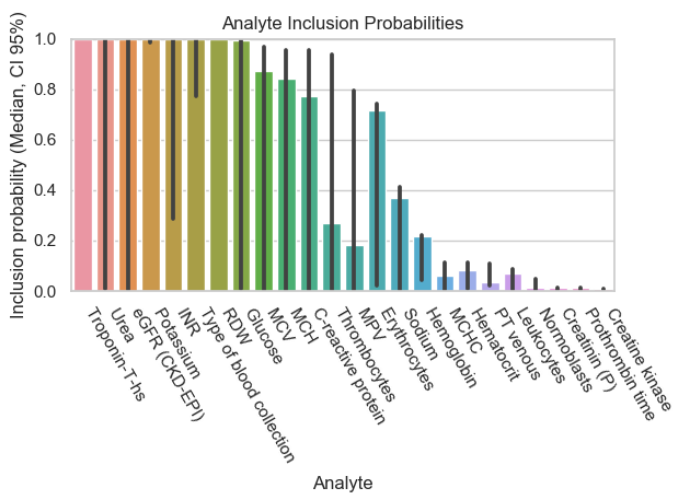
Figure 2. Inclusion probability of parameters based on a data subset with initially 40% missing values. More analytes have a high predictive value with a bigger data subset. Those showing an inclusion probability of 95% and above are the following: TnT, potassium, urea, eGFR (glomerular infiltration rate), RDW (red distribution width), glucose, INR (international normalized ratio), and the type of blood collection (arterial or